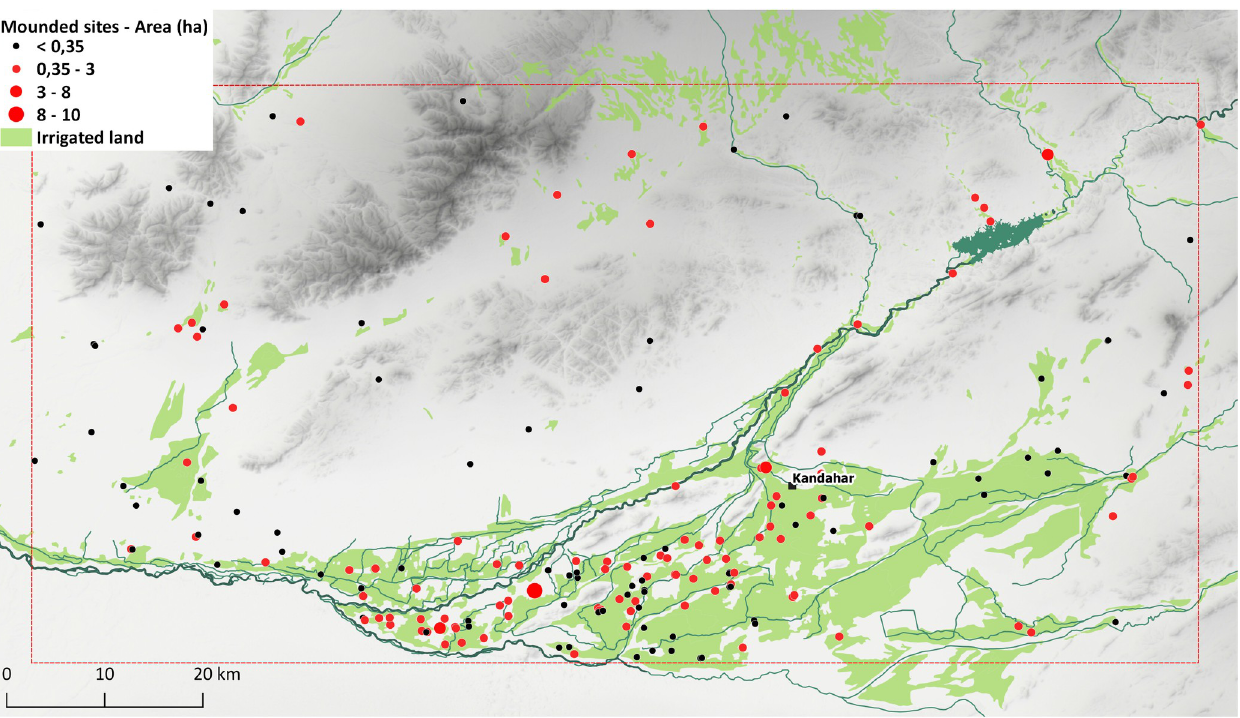
Fig 3. Map showing the distribution of mounded sites. DEM based on Shuttle Radar Topography Mission (SRTM) 1 Arc-Second Global courtesy of the U. S. Geological Survey (doi:10.5066/F7PR7TFT) (https://earthexplorer.usgs.gov). The map was created by the authors in QGIS.